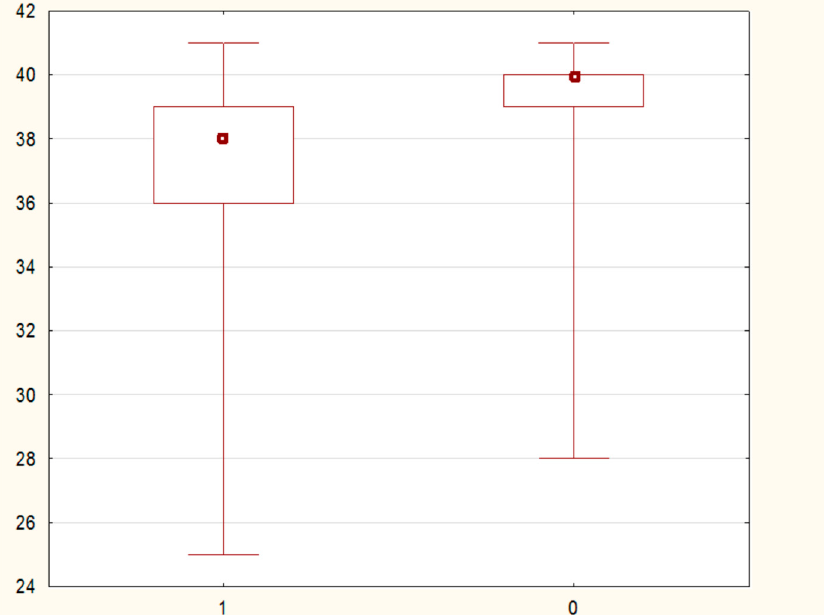
Figure 3. A box-whisker chart showing the comparison of the duration of pregnancy (wks) parameter in the study-1 and control-0 groups.